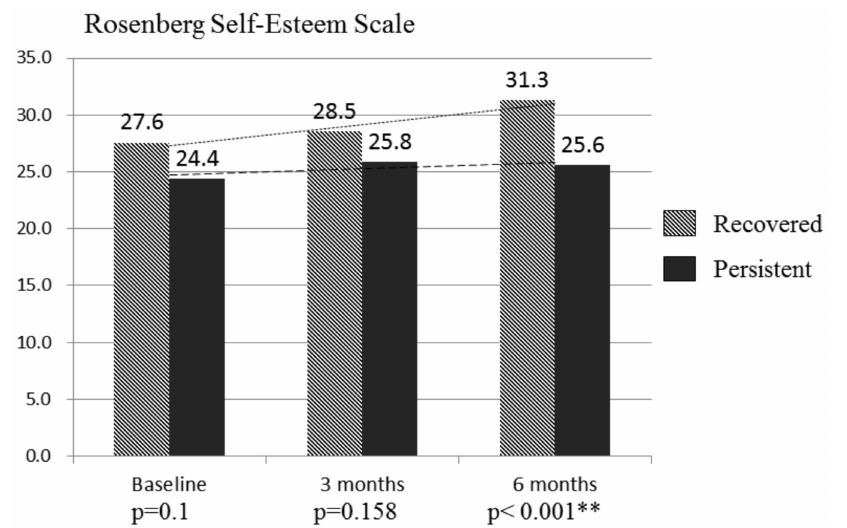
Figure 3. Follow-up comparison of self-esteem between the recovered and the persistent problematic smartphone users. ** p <